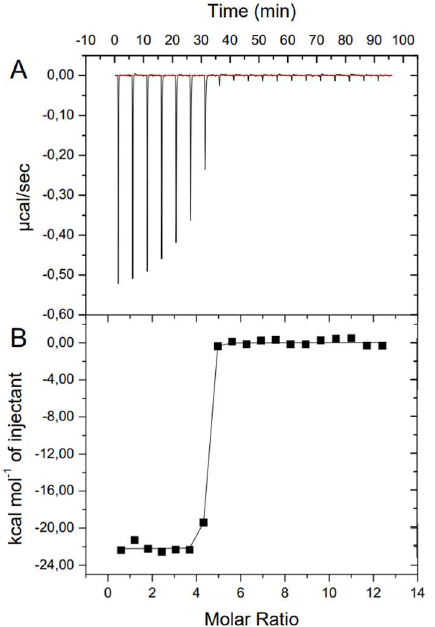
Fig. 3. (A) shows the raw data obtained from titrating biotin to STV plotted against time. The change in energy per second can be observed. It is also visible that between each titration sufficient time has passed that the reaction is finished and the solution equilibrated. (B) shows the energy change per mol of injectant, here B, plotted against the molar ratio of B and